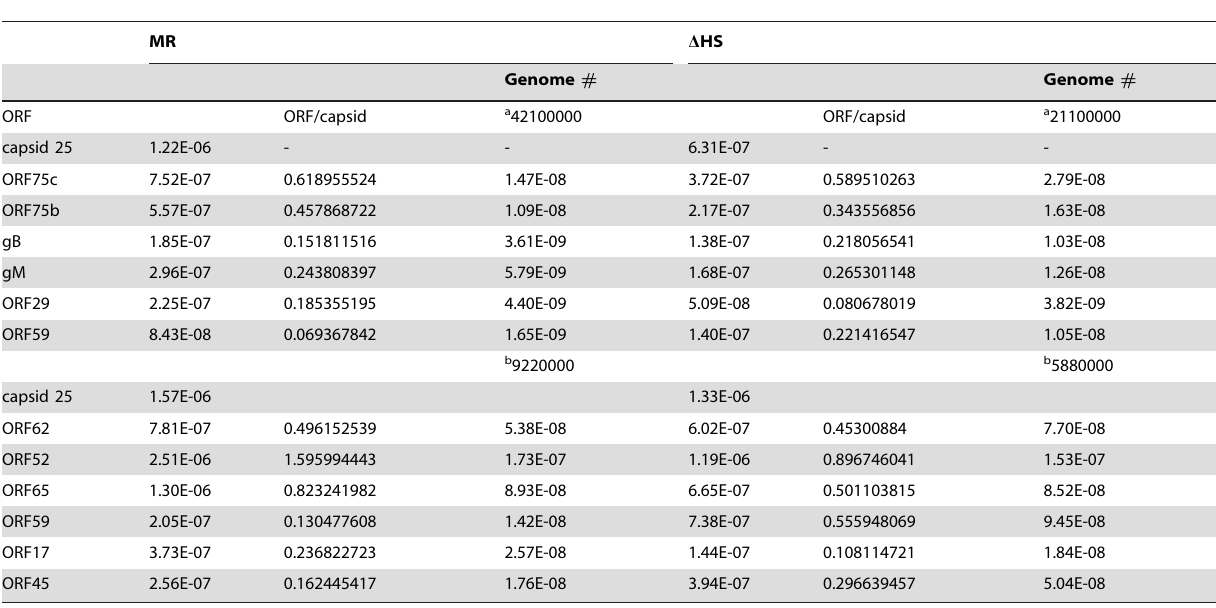
Table 1. Normalization strategy for mass spectrometry results.